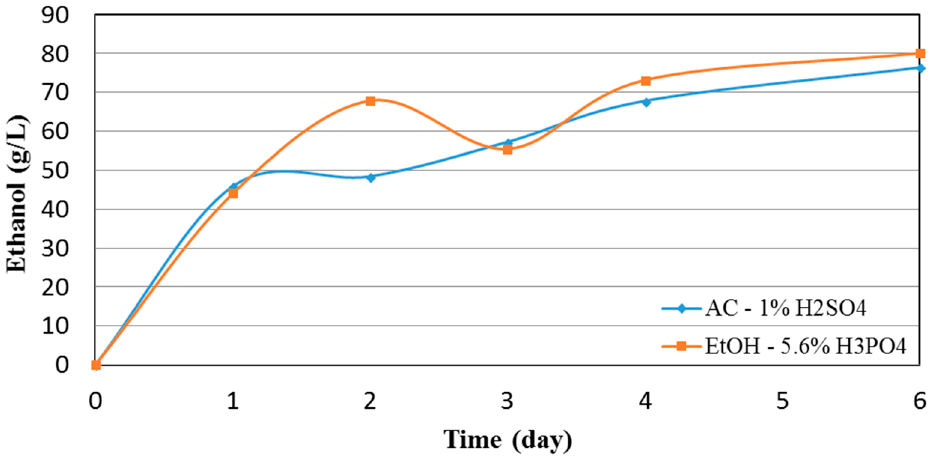
Figure 6. Ethanol concentration in high solids simultaneous saccharification and fermentation (SSF), an 8 h hydrolysis step preceded the SSF.